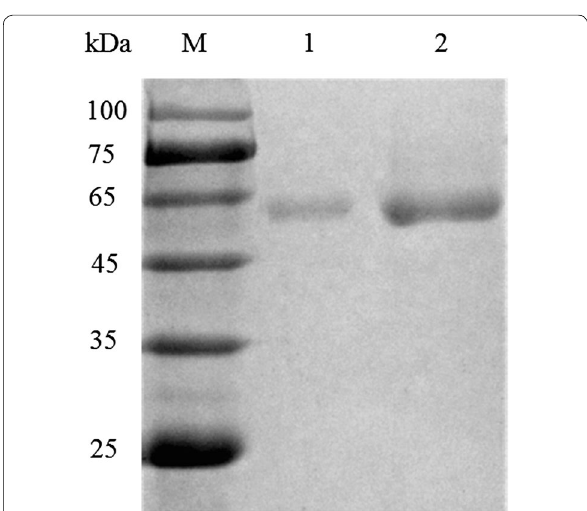
Fig. 4 SDS-PAGE analysis of purified recombinant Tl LipA. Lane M, the molecular weight standard markers; lane 1, the purified recombinant Tl LipA at 0.3 mg/mL; and lane 2, the purified recombinant Tl LipA at 3.0